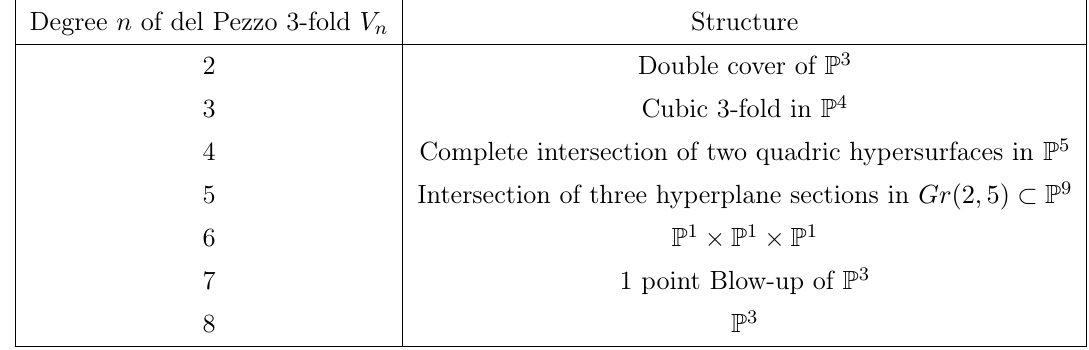
Table 1 . Del Pezzo 3-folds of degree d = 2 ; (cid:1) (cid:1) (cid:1) ; 8 [80–82] are listed. Gr (2 ; 5) in the table represents the complex Grassmannian of two-dimensional linear subspaces in C 5 . Gr (2 ; 5) is embedded inside P 9 via the Plücker embedding, and the del Pezzo 3-fold V in P 9 via the Veronese